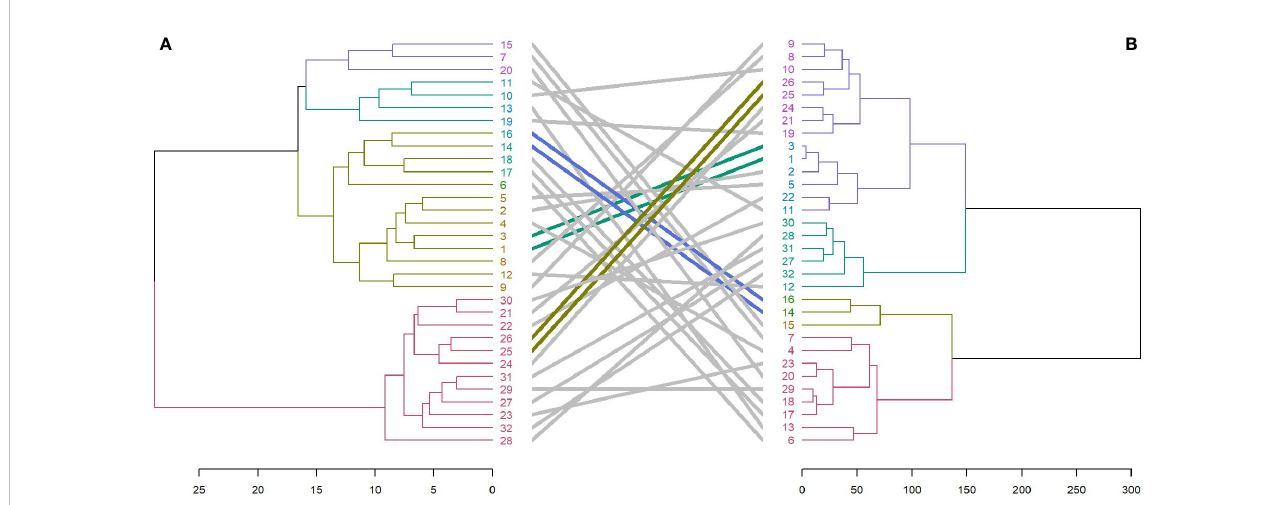
FIGURE 8 Comparison of dendrograms for the 32 Cyclamen genotypes from SRAP markers (A) , and phenotypic data (B) with entanglement = 0.30. The grey lines in connecting the dendrograms correspond to mismatched genotypes whereas the colored lines are genotypes that maintained their position between